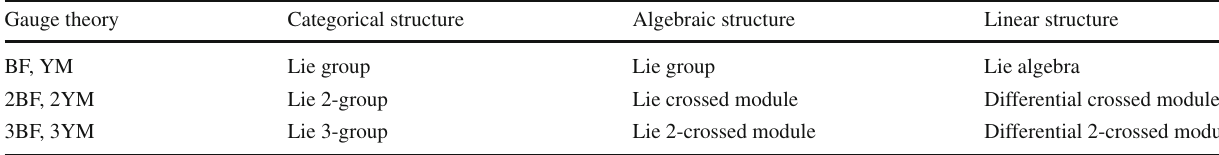
Table 1 The mathematical structures of (higher) gauge theories Gauge theory